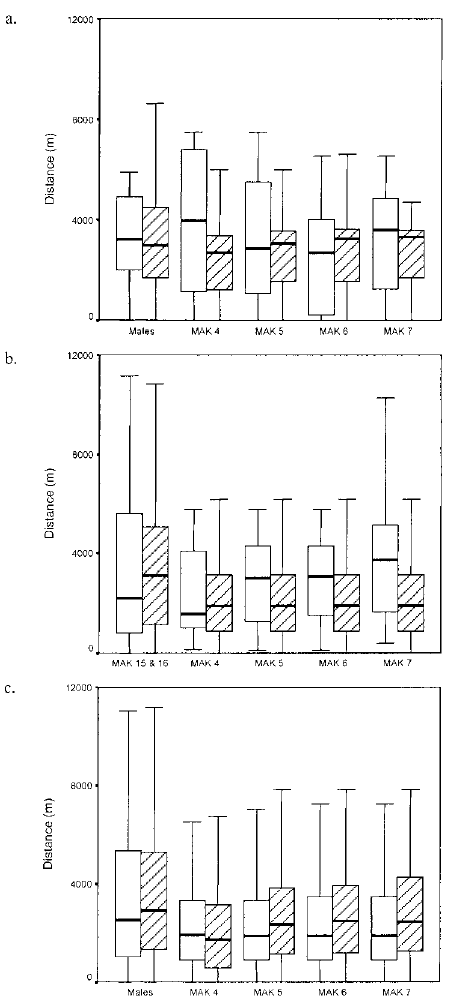
Fig. 4. The effect of management action on daily movement of the Makalali lions. (a) The effect of the introduction of new males to the Makalali Conservan- cy on the distance moved by the original lions in con- secutive days. Distances moved over the first six months post-release of the new males are indicated by hatched boxes, while the distances moved over the last six months the original lions were on the property are indicated by the clear boxes. (b) Effect of reserve area expansion on the distances moved by lions in consec- utive days. The six month period immediately before reserve expansion is shown by the clear boxes, while the first six months after fence removal was started are given by the hatched boxes. (c) The effect of season on distances moved by the Makalali lions in consecu- tive days. Summer is shown by the clear boxes, while winter is shown by hatched